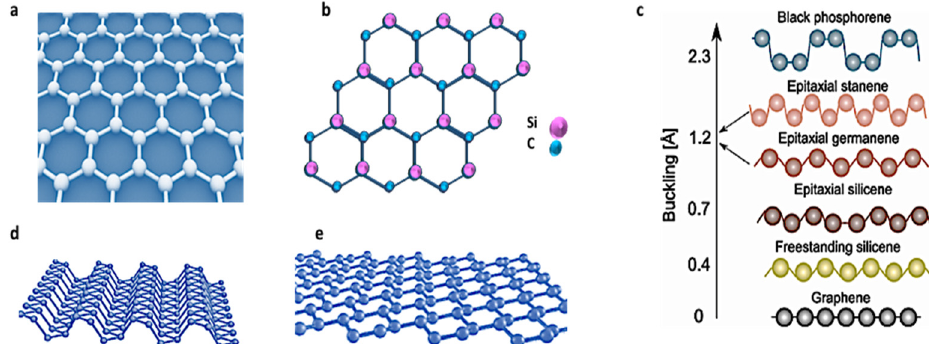
Figure 1. Schematics of crystal structure of graphene ( a ) and 2D SiC ( b ). Reported buckling for different 2D materials. ( c ) Unlike silicene and black phosphorous (BP), 2D SiC is 100% planar. ( c ) is reproduced from ref [15]. Atomic Structure of 2D black phosphorus ( d ). Credit: Institute for Basic Science. Atomic structure of silicene ( e ). Reprinted by permission from Nature [16], Copyright (2015).